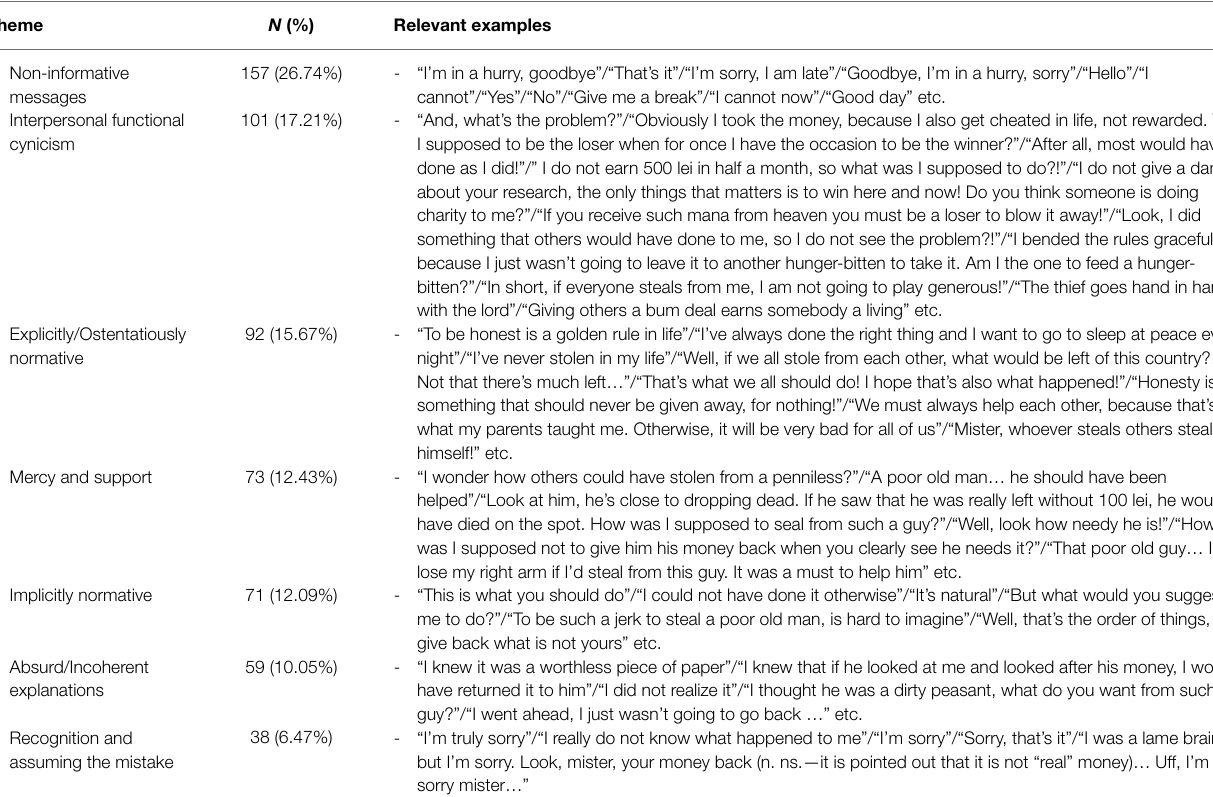
TABLE 4 | IPA matrix of referential themes and participants’ statements (global sample, N = 587). Theme N (%)